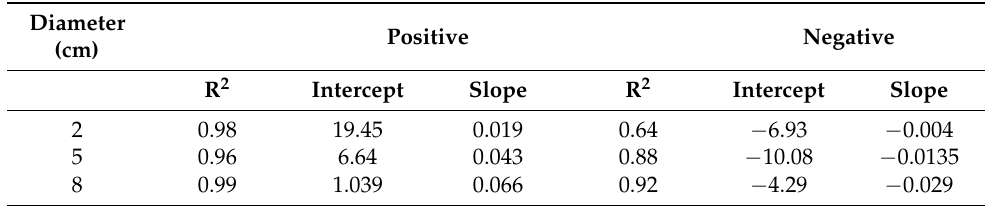
Figure 3. Linear curve fitting showing the relationship between laser energy and the acoustic pressure generated by CNT-PDMS composite transducers. It shows a linear relationship between laser energy and positive and negative acoustic pressures in all transducers, except the transducer with a 2 cm diameter, which shows saturation at − 10 MPa in negative pressure with the increase in laser energy. Table 2. R 2 , intercept, and slope values for 2 cm, 5 cm, and 8 cm transducers for both the positive and negative pressures presented in Figure 3.